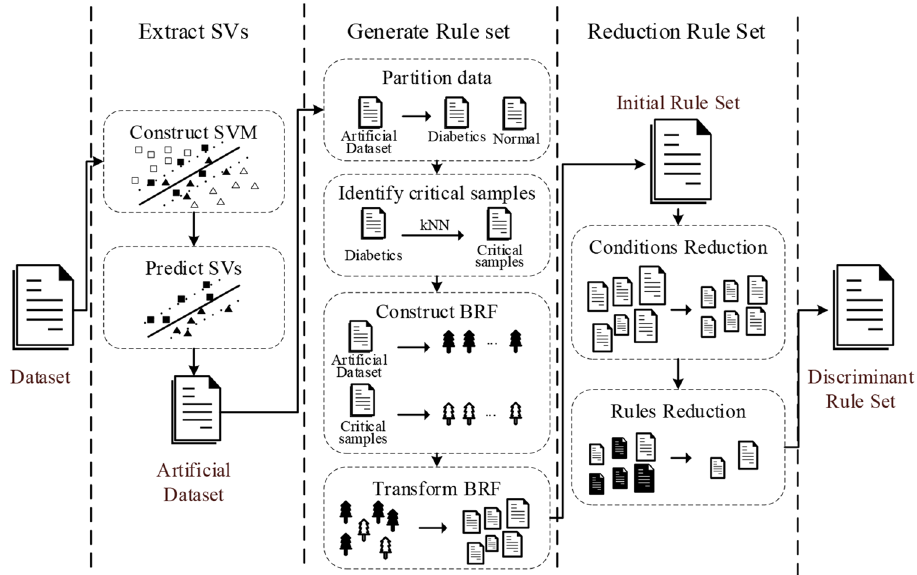
Figure 1. Schematic diagram of the proposed